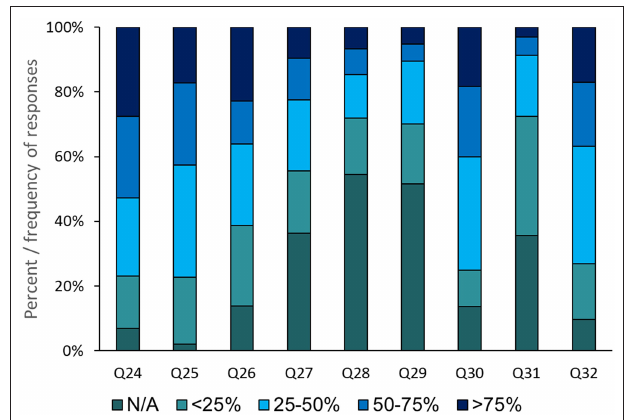
FIGURE 2 | Dentists’ responses on the economic impact of COVID-19 outbreak on their practice.